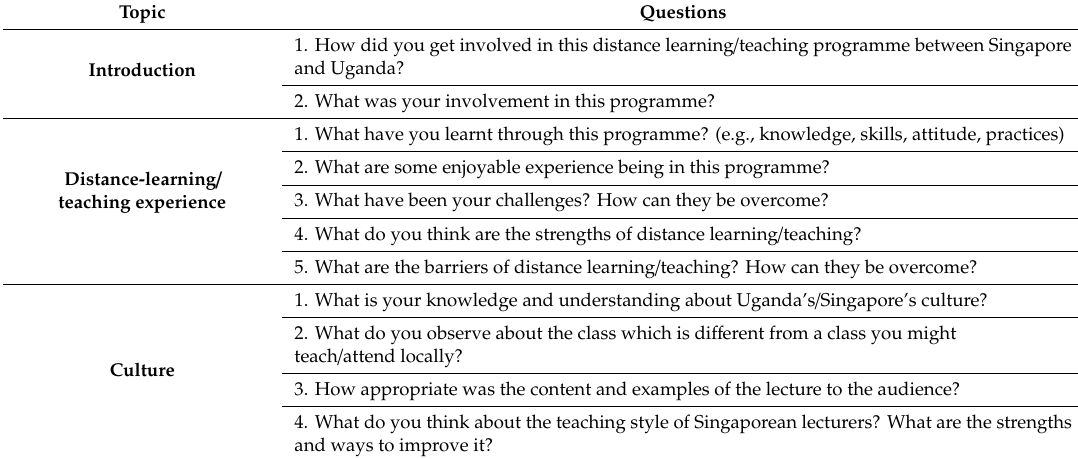
Table A2. Outline of an Interview Guide with Participants from Singapore and Uganda.